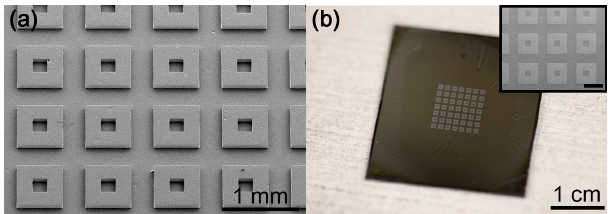
Figure 4. SEM and optical images demonstrating successful large area patterning of QD films utilizing SMP stamps. ( a ) SEM image of the array of SMP stamps and ( b ) optical image of the corresponding patterned QD film. Inset in ( b ) is an SEM image of the patterned QD film with 600 μ m scale bar.